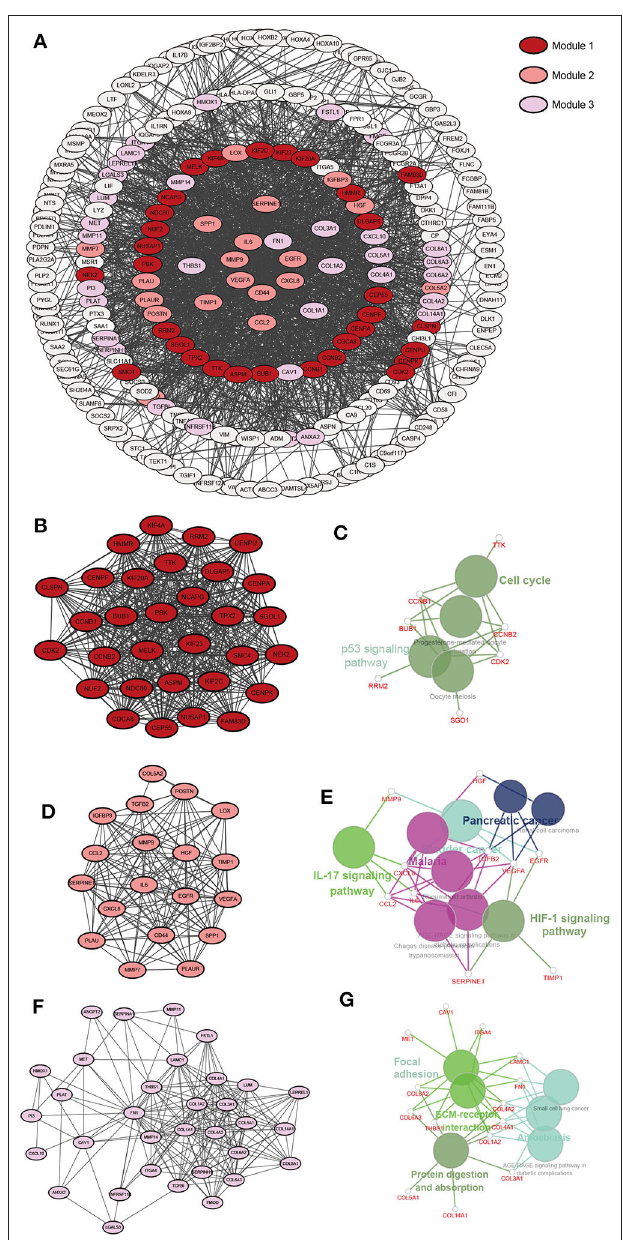
FIGURE 5 | A PPI network of DEGs upregulated in the RR-XPO1-high vs. RS-XPO1-low groups. Three significant modules were identified with an MCODE score of > 10. (A) A PPI network of GEDs that are up-regulated. (B) Module 1, MCODE score = 29.667. (D) Module 2, MCODE score = 15.556. (F) Module 3, MCODE score = 12.312. (C,E,G) Notable pathways where DEGs are enriched in module 1, module 2, and module 3.